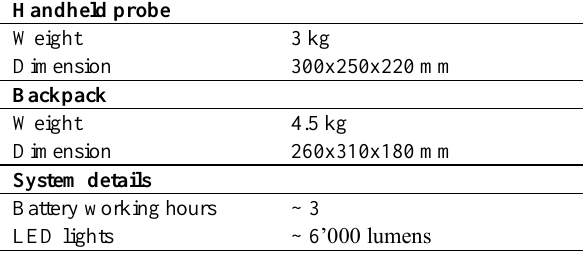
Table 4. Ant3D main specifications.